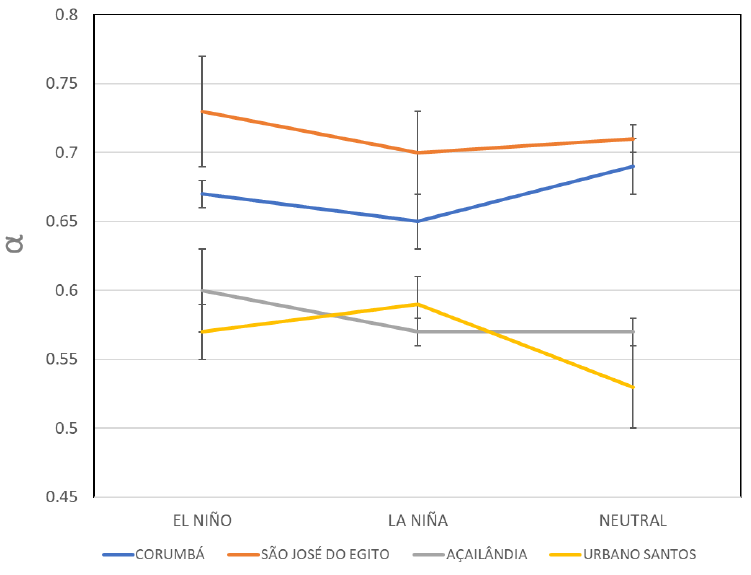
Figure 8. Cities that presented small range variations in the α for solar radiation for a time scale window greater than ten days. Corumbá, São José do Egito, Açailândia, and Urbano Santos have a persistent signal. The α , ranging through all studied seasons, never exceeded 0.05. This indicates some stability in the evaluated dataset. The error bar represents one standard error of the DFA